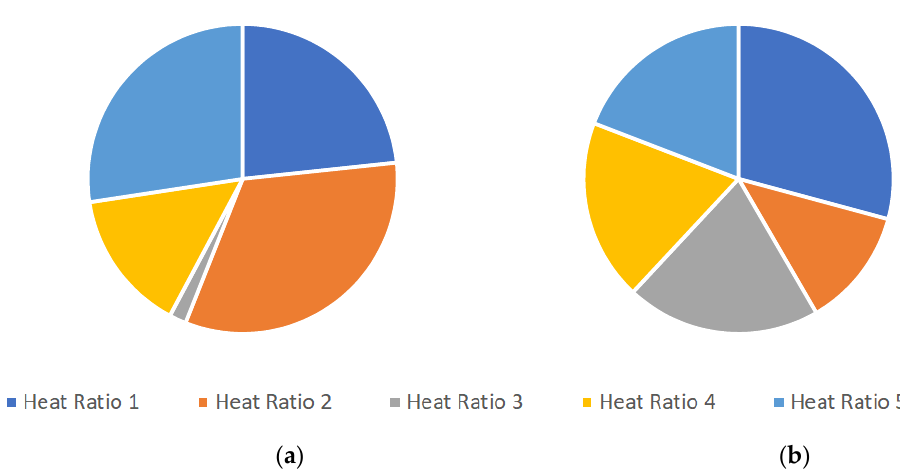
Figure 14. Energy ratio of top 2 layers per welding speed.